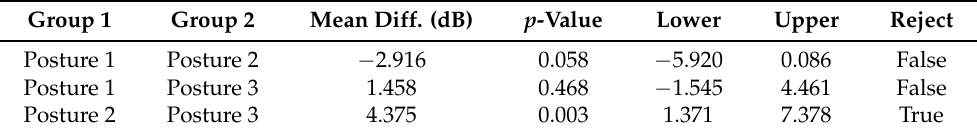
Table 5. Multiple comparison of TTS (125 Hz) means (Tukey HSD, FWER =